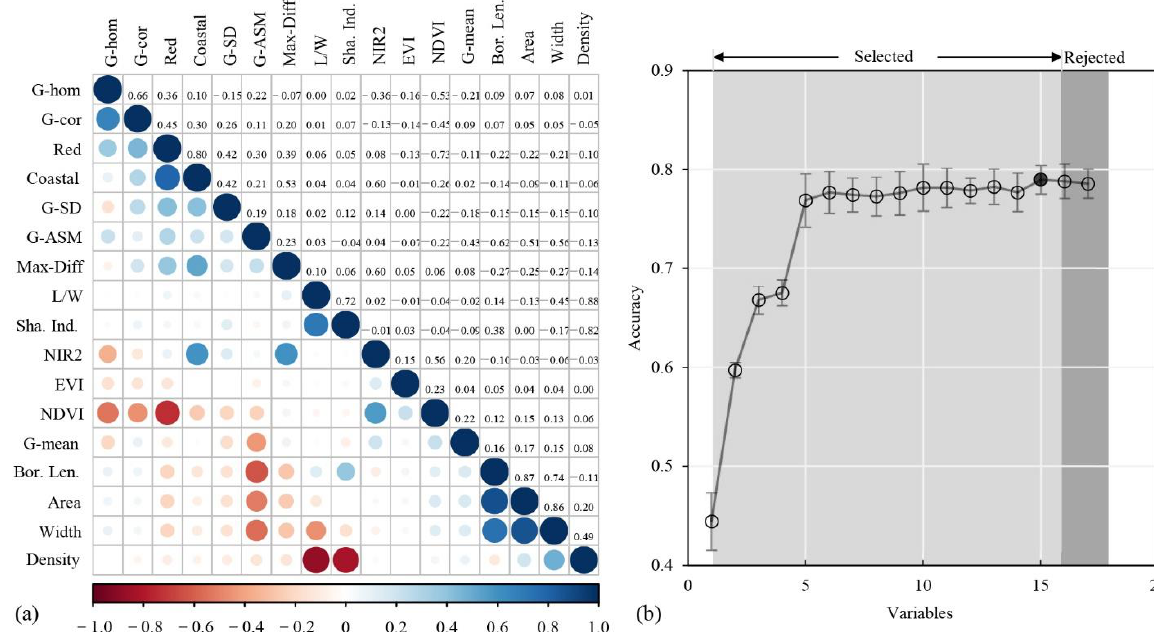
Figure 4. Initially, variables were selected via pairwise Pearson’s r between −0.9 and 0.9 ( a ). Fifteen variables were ultimately selected through further execution of the SVM-RFE method ( b ). G-ASM, GLCM ang. 2nd moment; G-cor, GLCM correlation; G-hom, GLCM homogeneity; G-mean, GLCM mean; G-SD, GLCM standard deviation; Bor. Len., border length; Sha. Ind., shape index; L/W, length/width; Max-Diff, maximum difference.